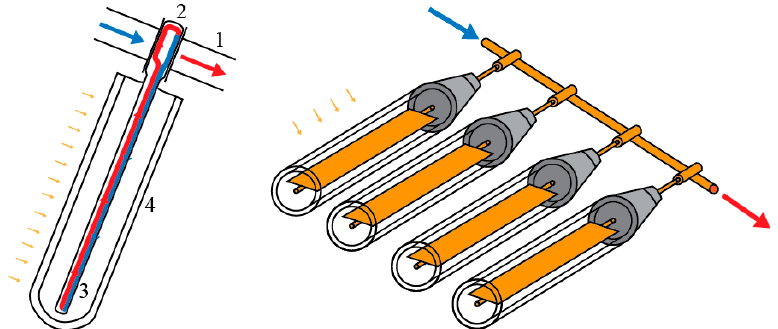
Figure 1. Operating principles and essential parts of a conventional evacuated tube solar collector: 1—manifold header, 2—heat pipe head, 3—heat pipe, and 4—vacuum glass tube.